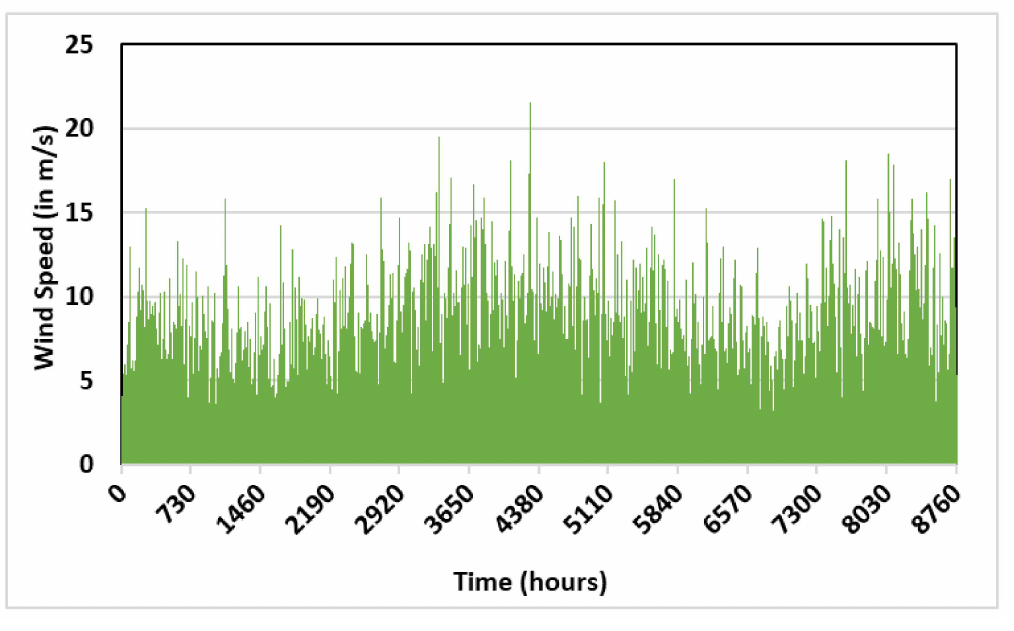
Figure 2. Velocity of wind at the location. Table 1. Specifications of the wind turbine